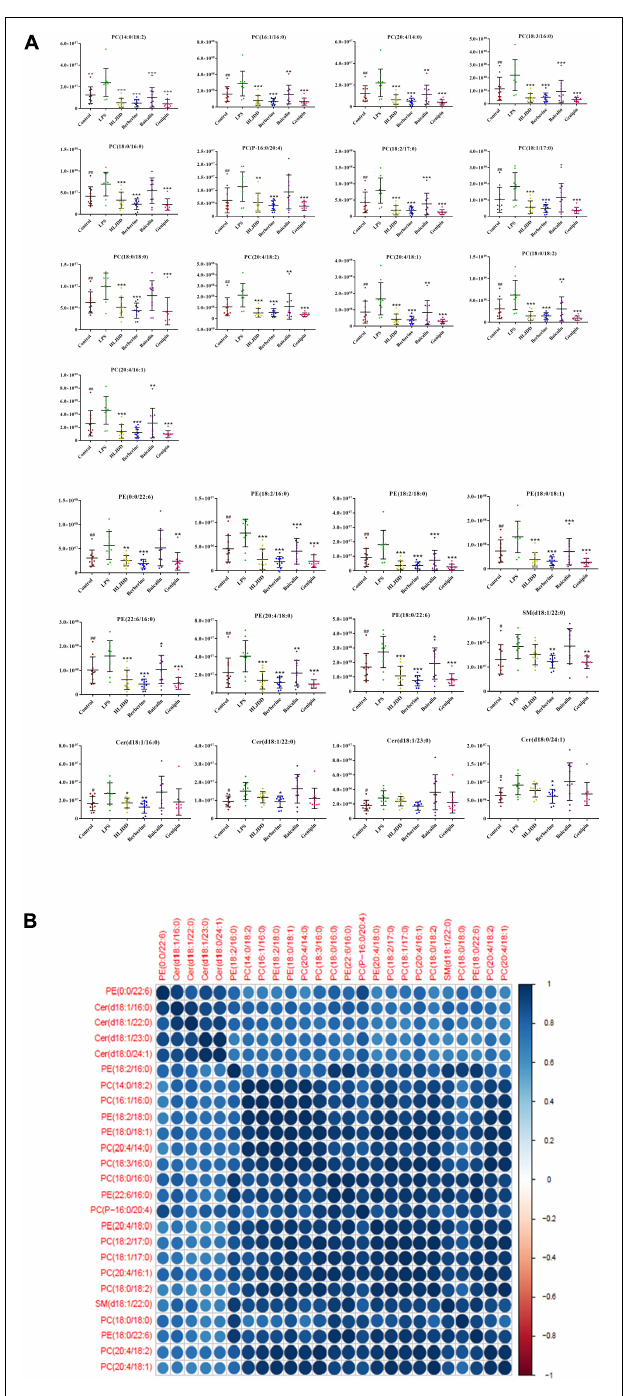
FIGURE 5 | Multivariate statistical analysis of the lipopolysaccharide (LPS) group and control group. (A) The metabolic changes of 25 potential lipid markers in LPS group. ∗ P < 0.05, ∗∗ P < 0.01, and ∗∗∗ P < 0.001, four drug treatment groups compared to the LPS group. # P < 0.05 and ## P < 0.01, LPS group compared to the control group. (B) Relationship of correlation matrix between clusters of 25 potential lipid markers. Different color scales reflect the magnitude and direction of correlation between different lipids. Blue and red indicate positive and negative correlations,